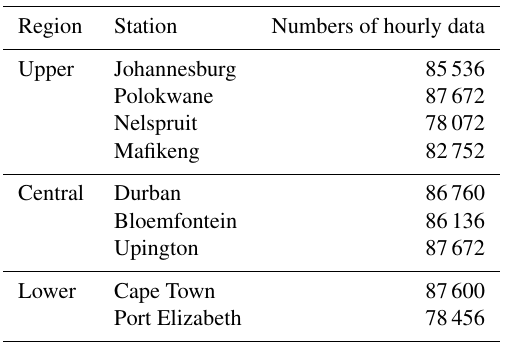
Table 1. A summary of the stations and numbers of hourly data obtained from each